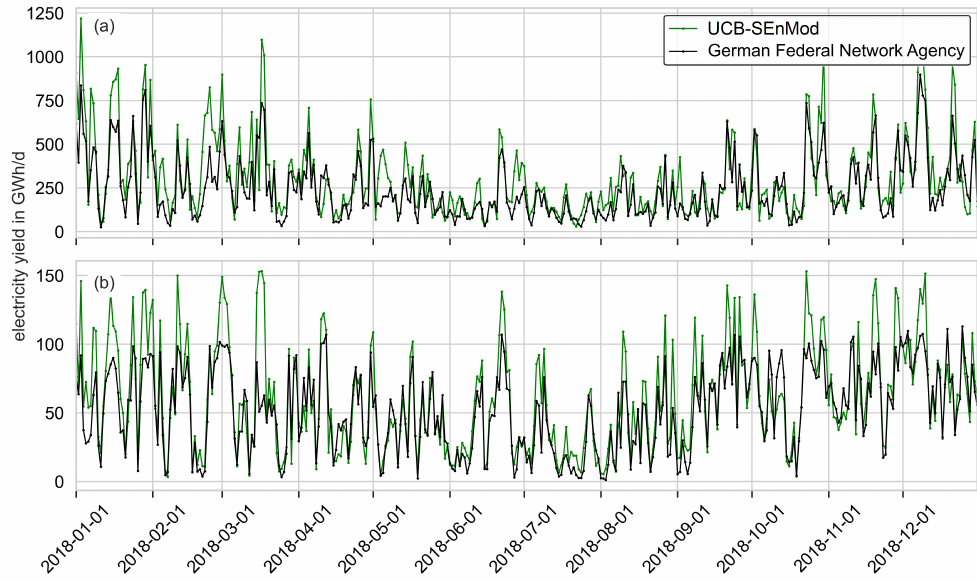
Figure 4. The upper part ( a ) shows the validation of onshore wind power simulations and the lower part ( b ) for offshore wind power—both using Germany as an example in 2018 with data from the German Federal Network Agency. The data are trend-adjusted and aggregated to daily sums. Even under quite simple assumptions, the validation shows promising results. However, the data of the German Federal Network Agency (shown in black) partly differ significantly from the simulated data (shown in green). It is again mentioned that by simulating several plants in regions with different climatic conditions, the RMSE will